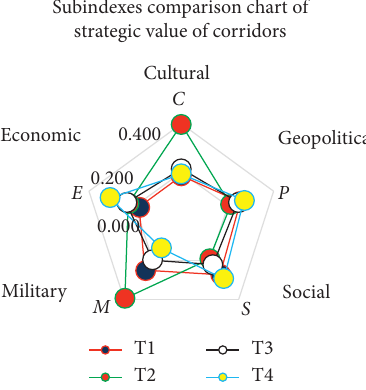
Figure 4: Comparison of SVITC for T1, T2, T3, and T4 by subindexes.